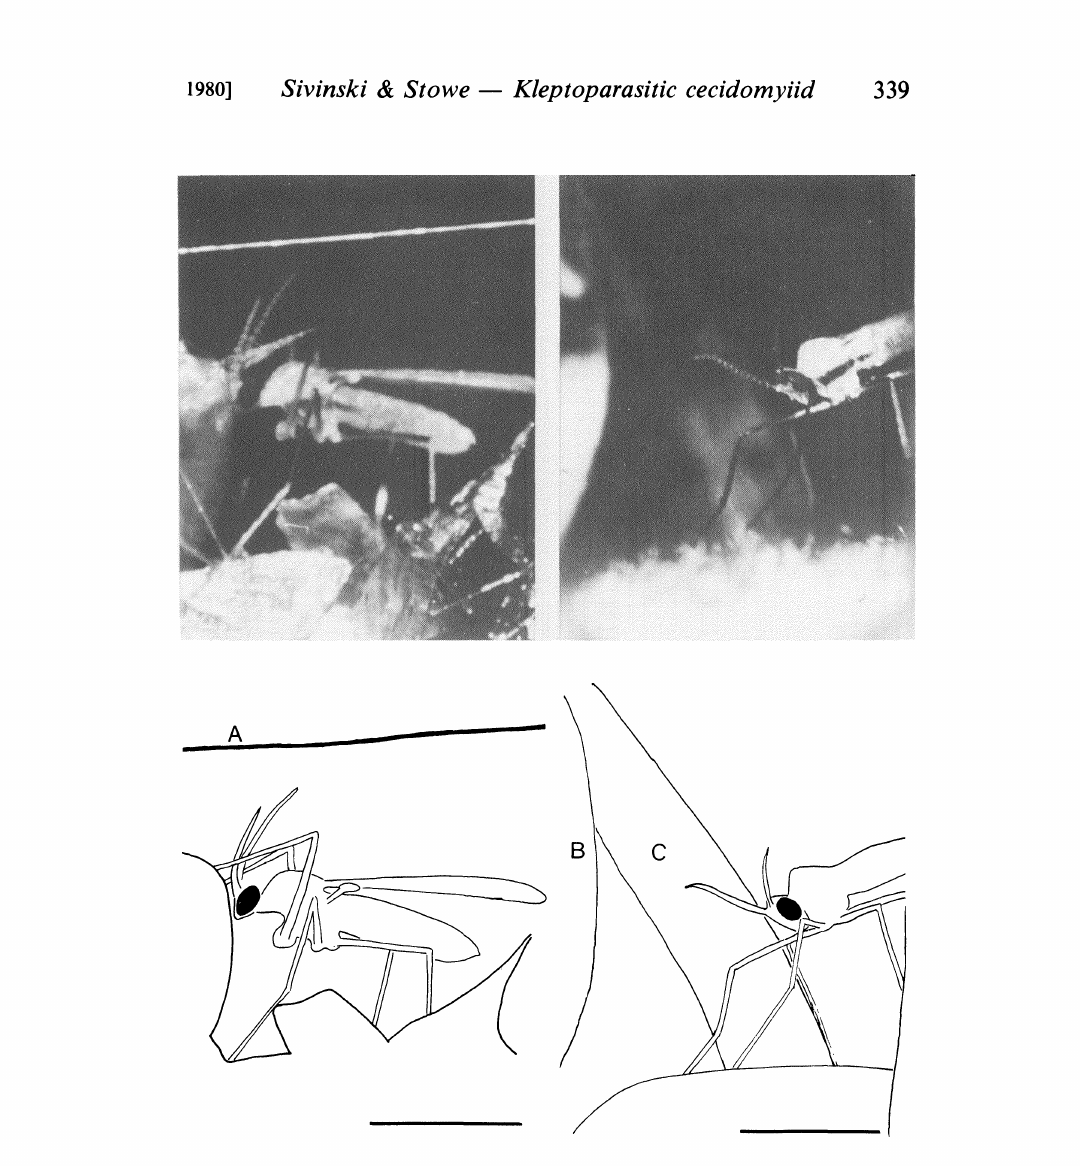
Figure 1. (left) A female Didactylomyia longimana perched on the partially consumed prey of Nephila clavipes; (right) D. longimana female on the cephalothorax of Argiope aurantia. A) line in Nephila web; B) anterior end of abdomen; C) leg (space bars